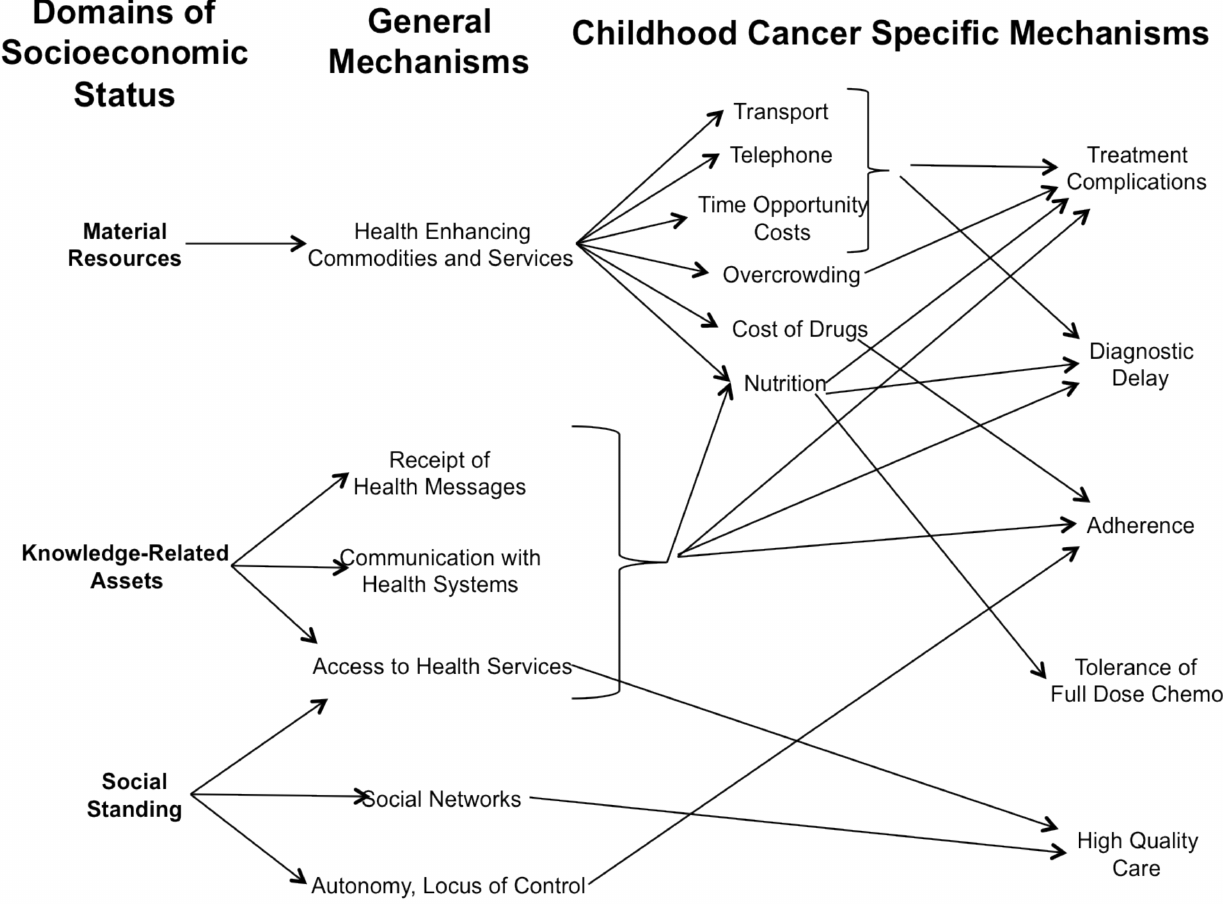
Figure 4. Mechanisms linking socioeconomic status domains to both general and childhood cancer specific health outcomes. Domains and general mechanisms are adapted from the work of Galobardes et?al., Braveman et?al., Krieger et?al. and Marmot. Several childhood specific mechanisms are suggested by Bhatia et?al., Gage, Viana et?al. and Gupta et?al. These mechanisms are often theoretical with little empiric basis. axis may represent stronger, weaker or equivalent associations than proximal points. Table S1 Eligible studies examining the impact of socioeconomic status upon outcome in children with cancer in low- and middle-income countries. ALL – acute lymphoblastic leukemia; AML – acute myeloid leukemia; DFS – disease free survival; EFS – event free survival; HR – hazard ratio; N – number; OS – overall survival; SES – socioeconomic status; TRM – treatment related mortality. Bolded variables indicate statistically significant associations. a The marginalization index used by Carlos et?al. is an ecologic measure of SES; all other variables in the table are measures of individual-level SES. Table S2 Eligible studies examining the impact of socioeconomic status upon outcome in children with cancer in high-income countries. ALL – acute lymphoblastic leukemia; AML – acute myeloid leukemia; CNS – central nervous system tumors; EFS – event free survival; ES – Ewing sarcoma; GCT – germ cell tumors; HR – hazard ratio; MB – medulloblastoma; N – number; NB – neuroblastoma; NHL – non-Hodgkin lymphoma; OR – odds ratio; OS – overall survival;